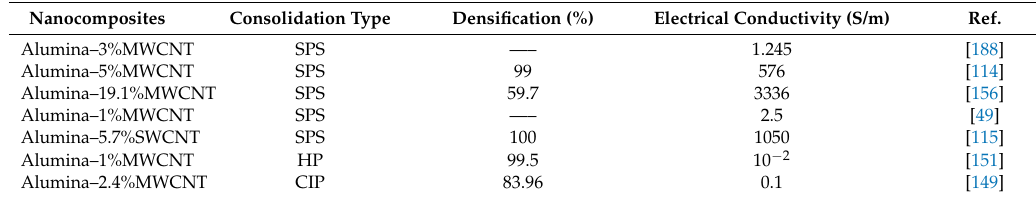
Table 6. Electrical conductivity of alumina–CNT